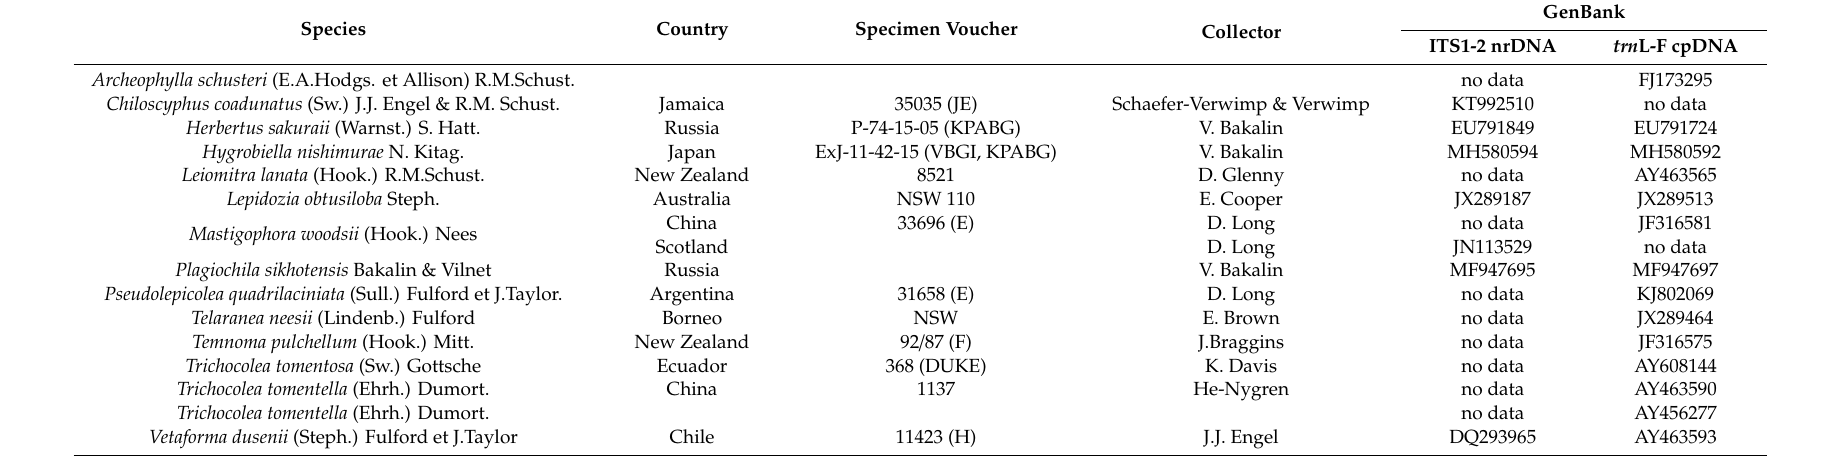
Table 2. The list of taxa with specimen vouchers and GenBank accession numbers for the